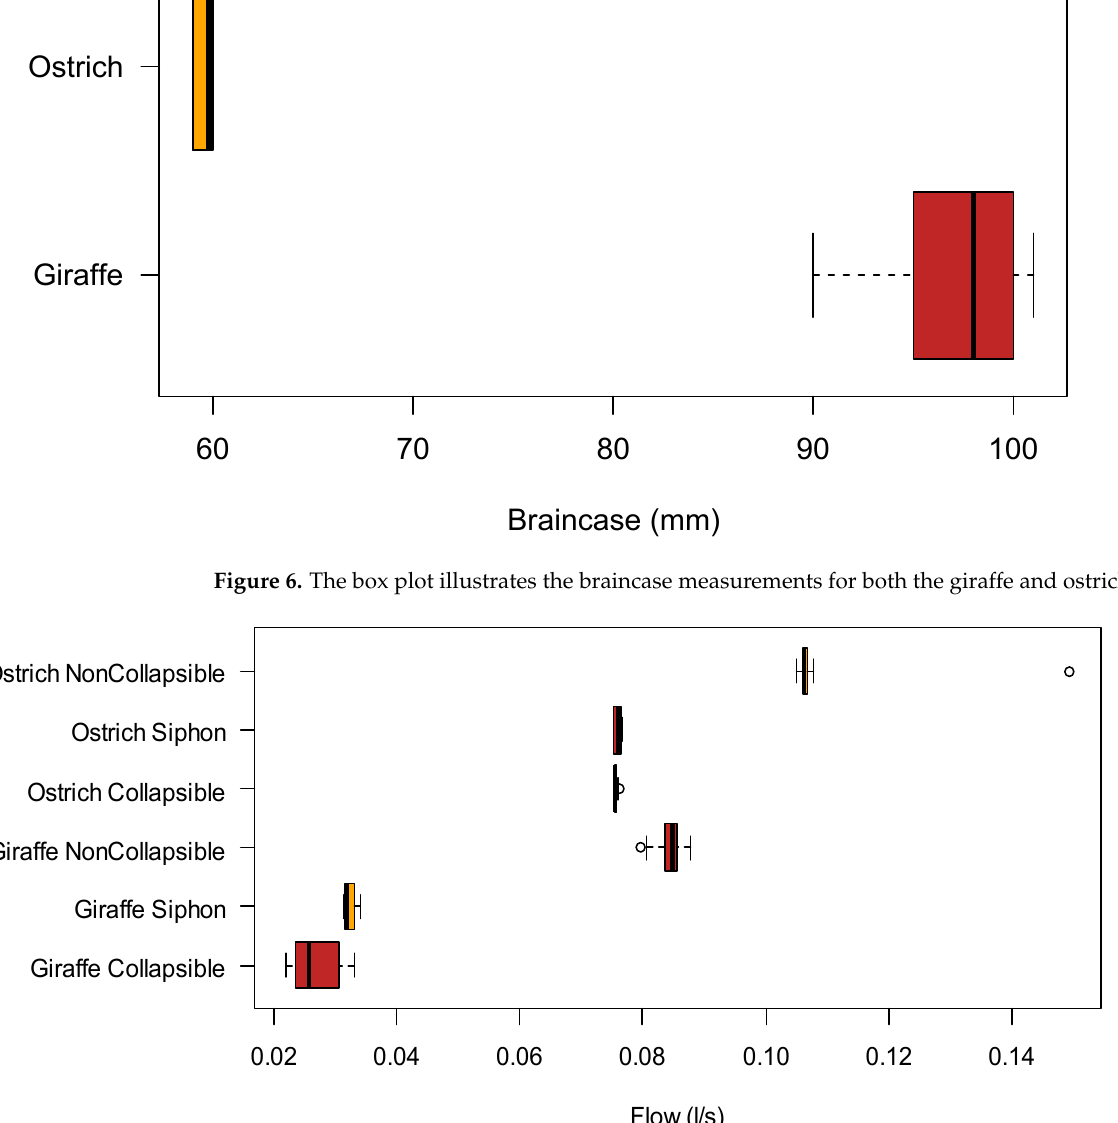
Figure 7. Distribution of flow simulation values of each measurement (L/s) (collapsible tube, non- collapsible tube, collapsible tube with siphon) for each species, with outliers included as indicated by white circle.